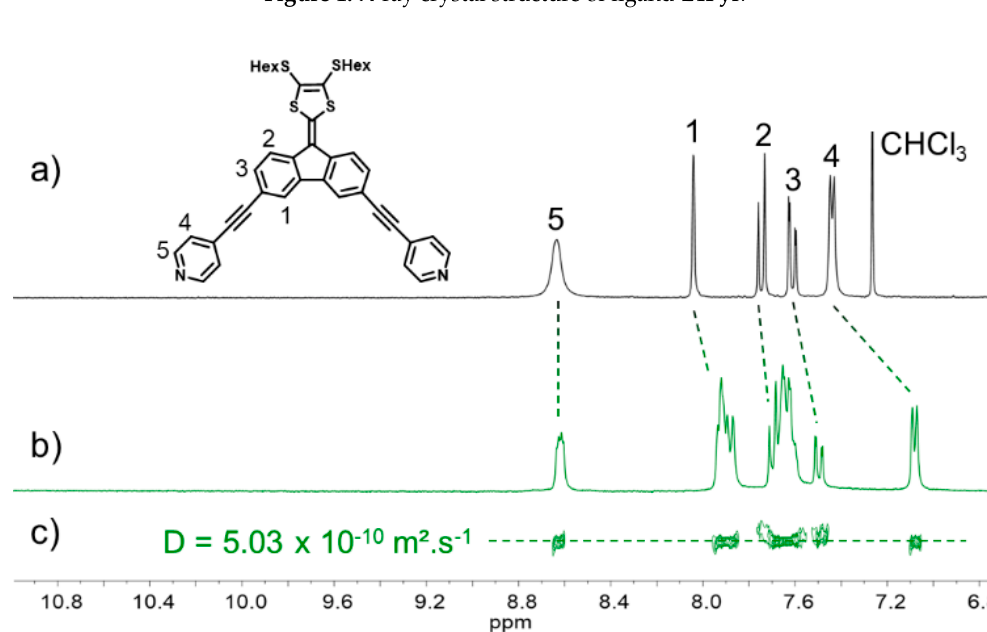
Figure 2. 1 H-NMR spectra (aromatic region) of ( a ) ligand L4Pyr (CDCl 3 ), ( b ) metalla-macrocycle [ Pd 2 (L4Pyr) 2 (OTf) 4 ] (CD 2 Cl 2 ) and ( c ) corresponding 1 H-NMR DOSY spectra (related to ( b )).